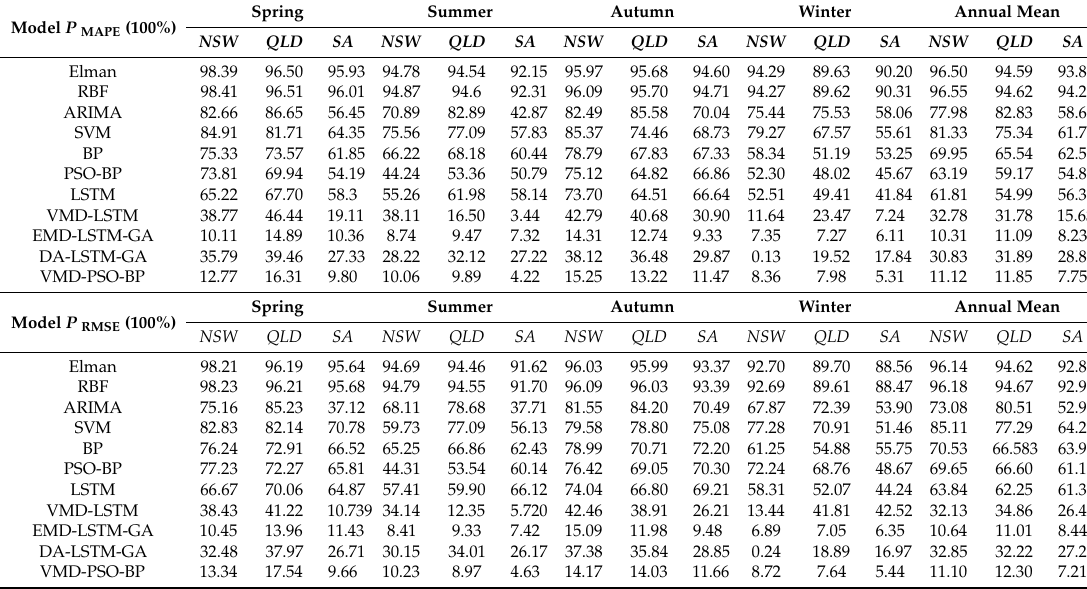
Table 15. Improvement percentage of the proposed